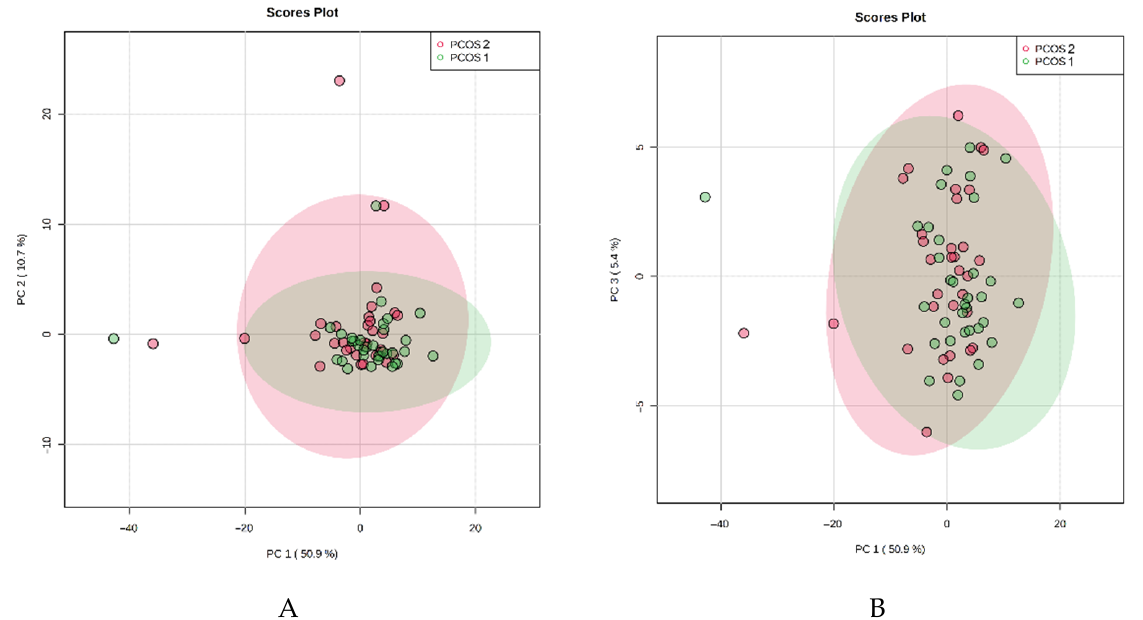
Figure 3. The unsupervised multivariate principal component analysis (PCA) of the studied metabolites in the PCOS-1 and PCOS-2 groups. The plots represent the first principal component (PC1) against the second principal component (PC2) ( A ) and the first principal component (PC1) against the third principal component (PC3) ( B ).